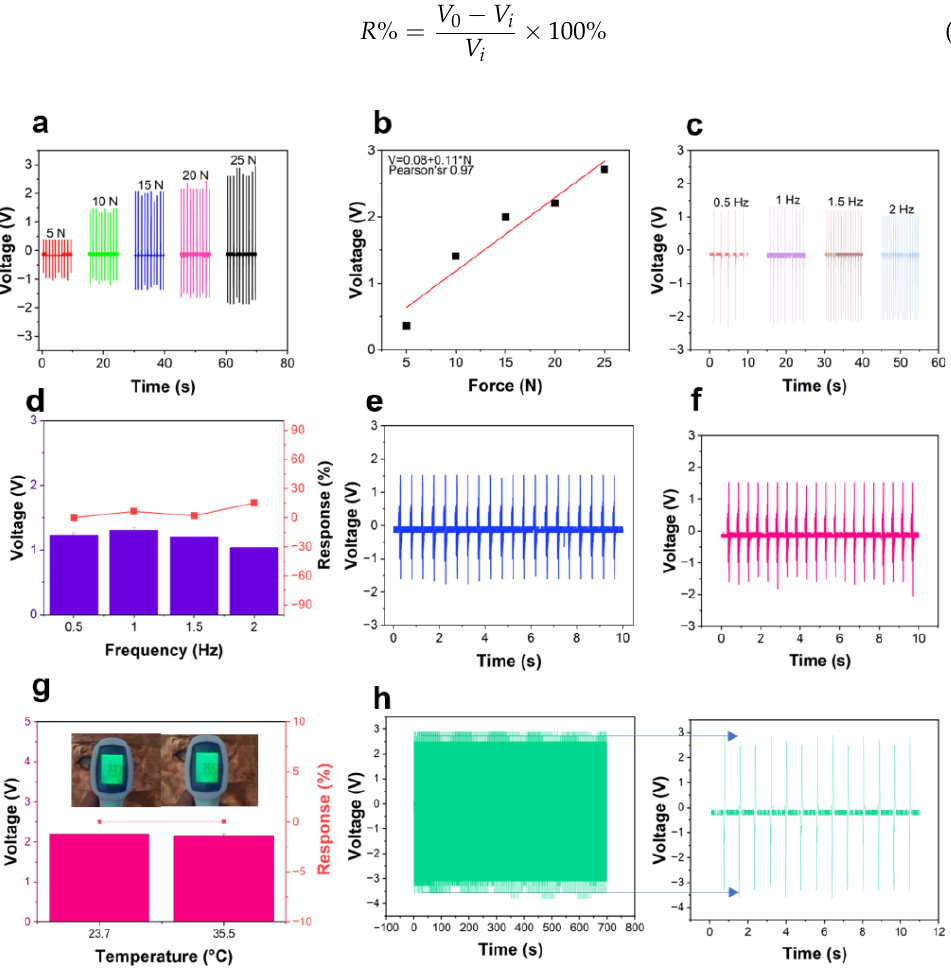
Figure 3. The output performance of the PL-TENG. ( a ) PL-TENG output voltage comparison under different pressures. ( b ) Linearity of the PL-TENG output voltage under different pressures. ( c ) PL-TENG output voltage comparison under different frequencies. ( d ) PL-TENG output voltage response under different frequencies. ( e ) PL-TENG output in dry conditions (voltage). ( f ) Output voltage of the PL-TENG after wetting. ( g ) Output voltage of the PL-TENG at different temperatures. ( h ) Durability test of the PL-TENG.